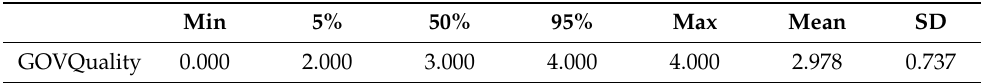
Table 5. CG index distribution (percentiles, mean and standard